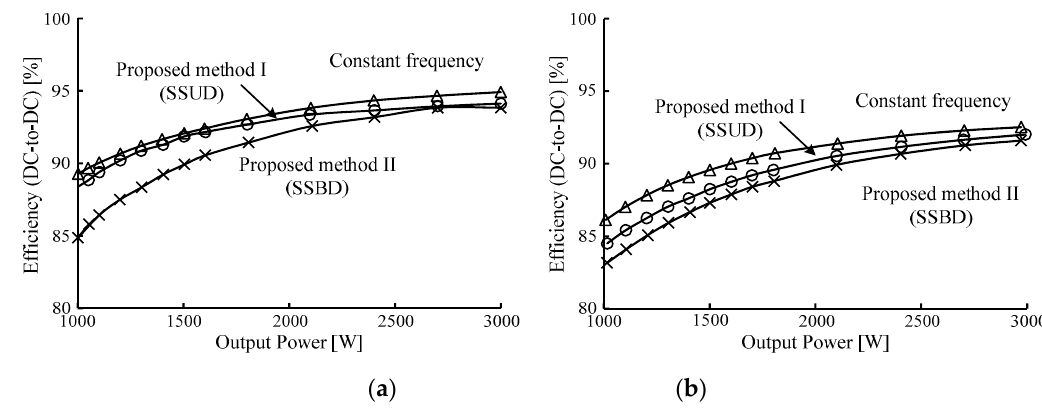
Figure 12. Efficiency characteristic with ( a ) SS compensation, and ( b ) SP compensation. Figure 12. E ffi ciency characteristic with ( a ) SS compensation, and ( b ) SP